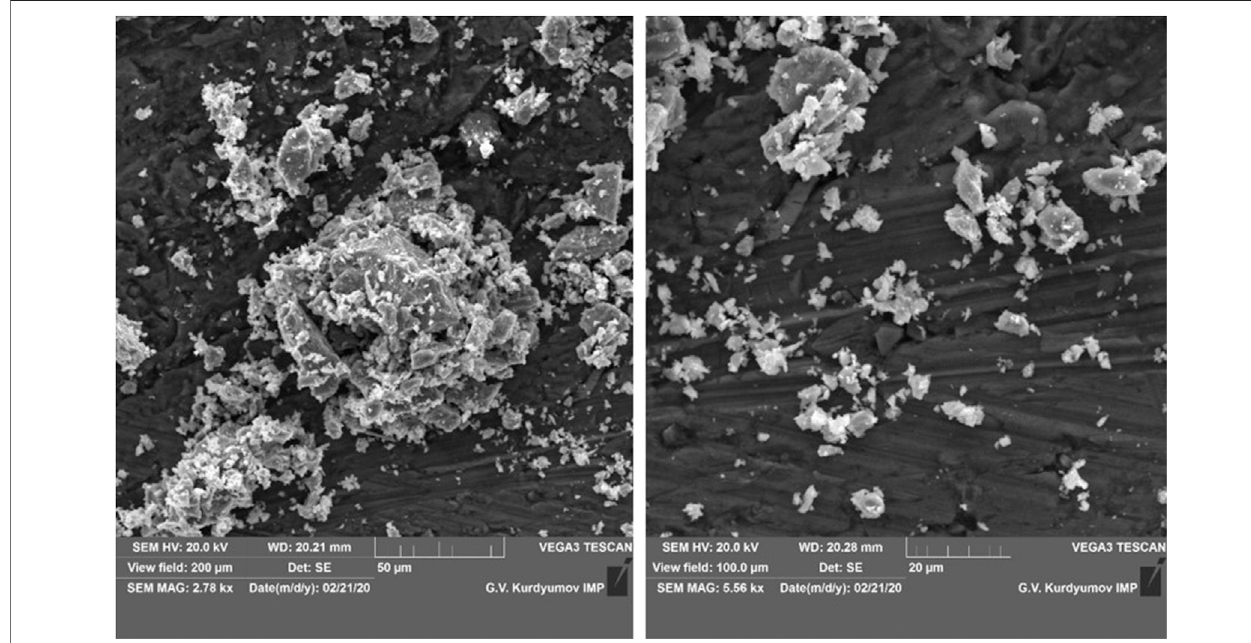
FIGURE 6 | SEM images of hydrogenated pre-alloyed powders.